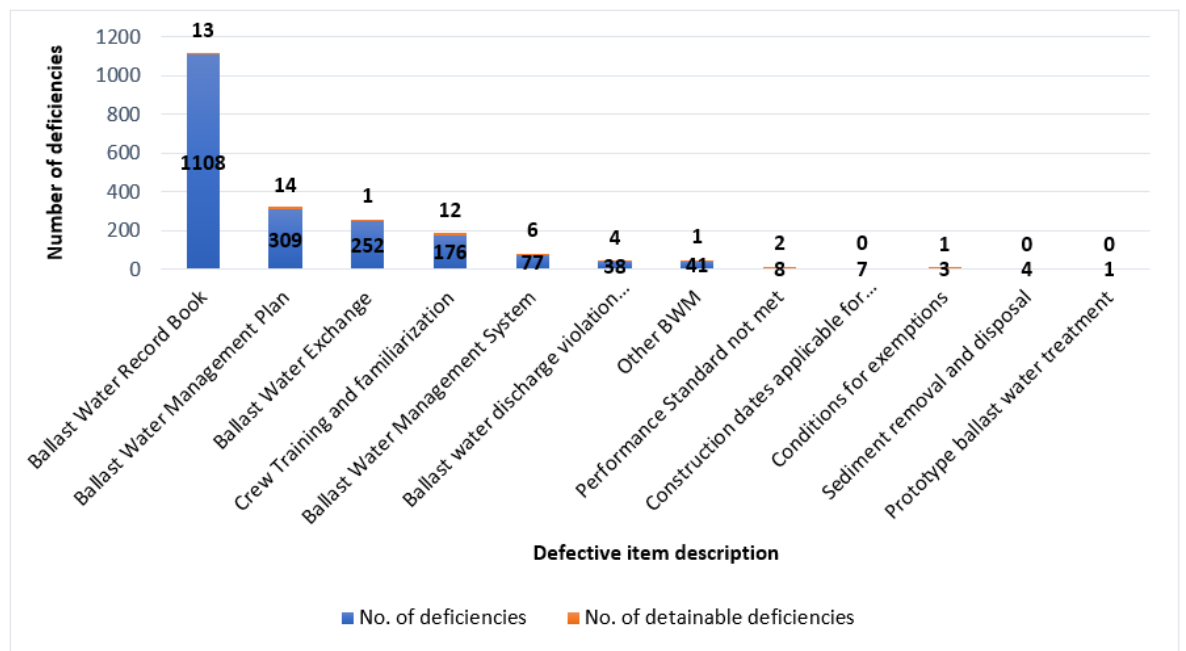
Figure 1. BWM deficiencies identified by the Paris MoU inspection regime from January 2019 to June 2022. Source: authors as per [46].